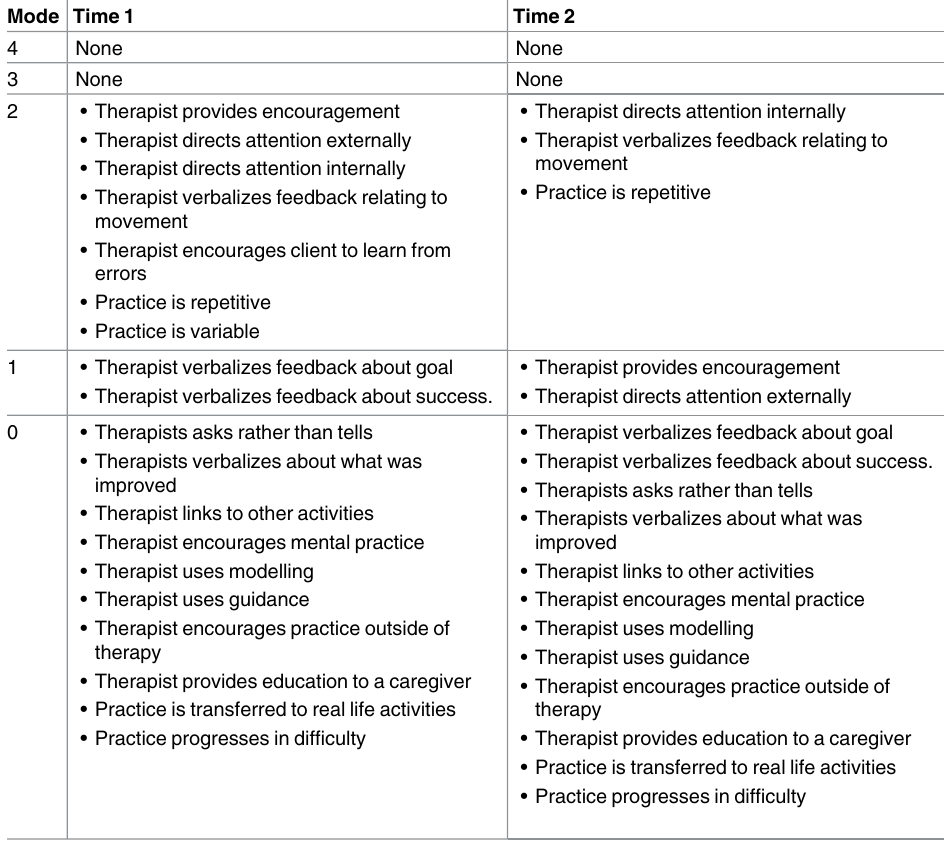
Table 5. Motor Learning Strategy Rating Instrument-20 Modes at Time 1 and Time